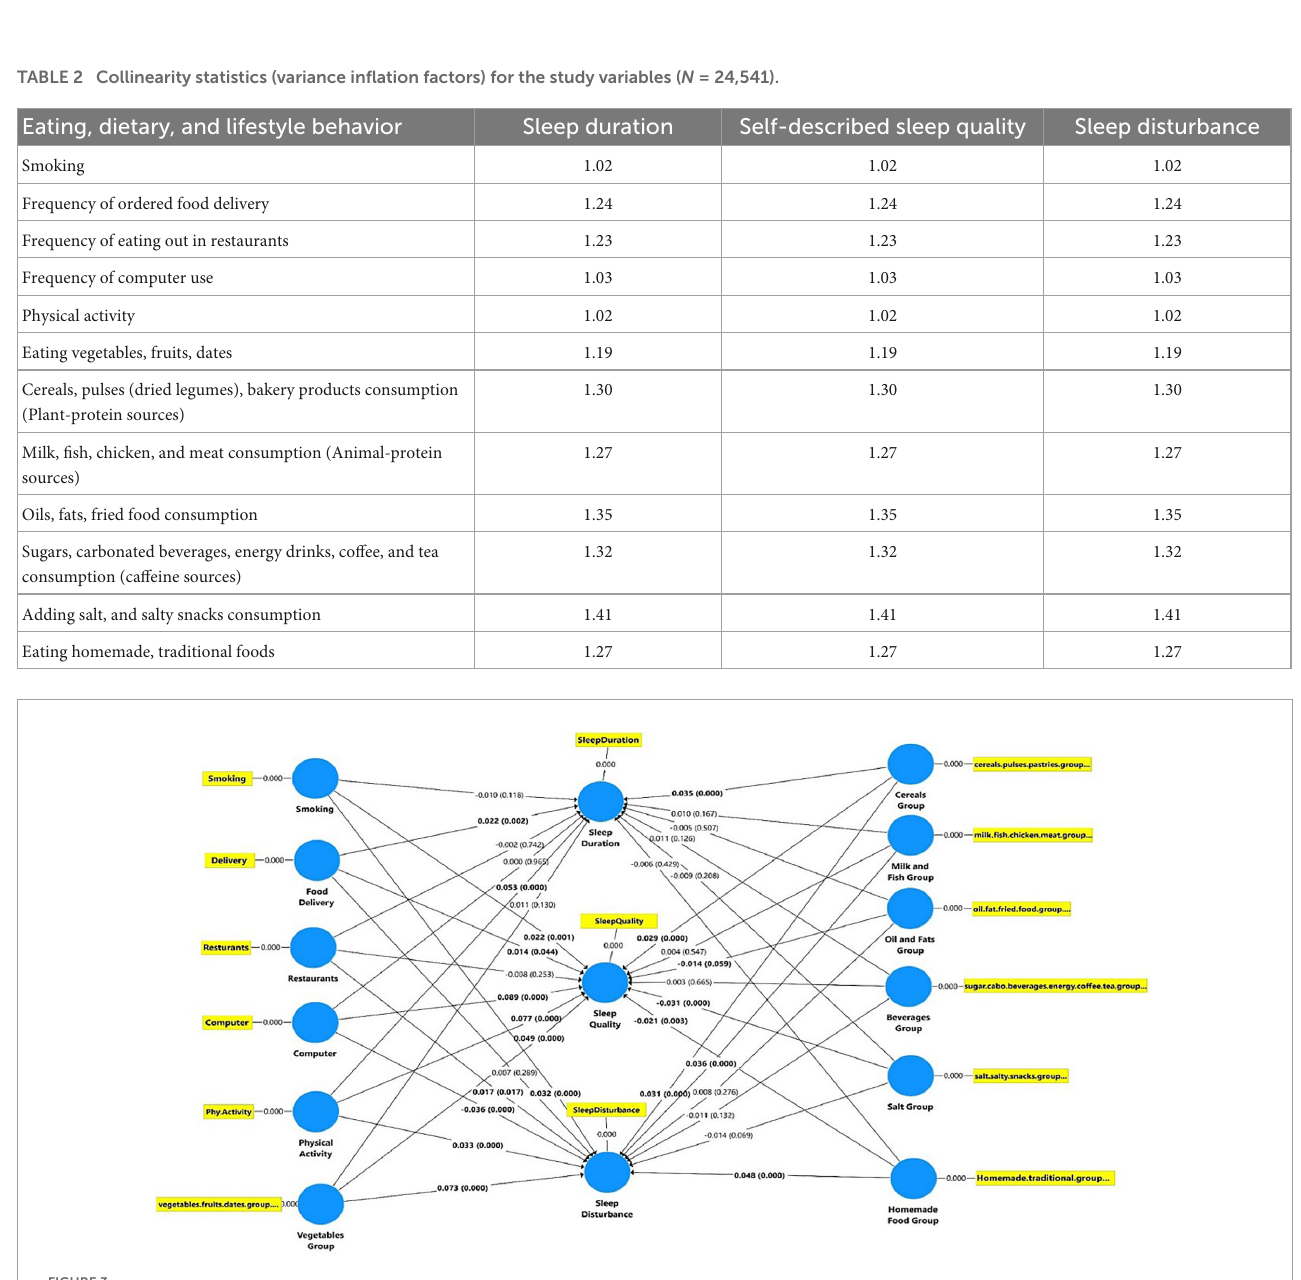
FIGURE3 Structural equation modeling (SEM) for the relationships between sleep components and the dietary and lifestyle behaviors during Ramadan fasting month among the 24,500 study participants.